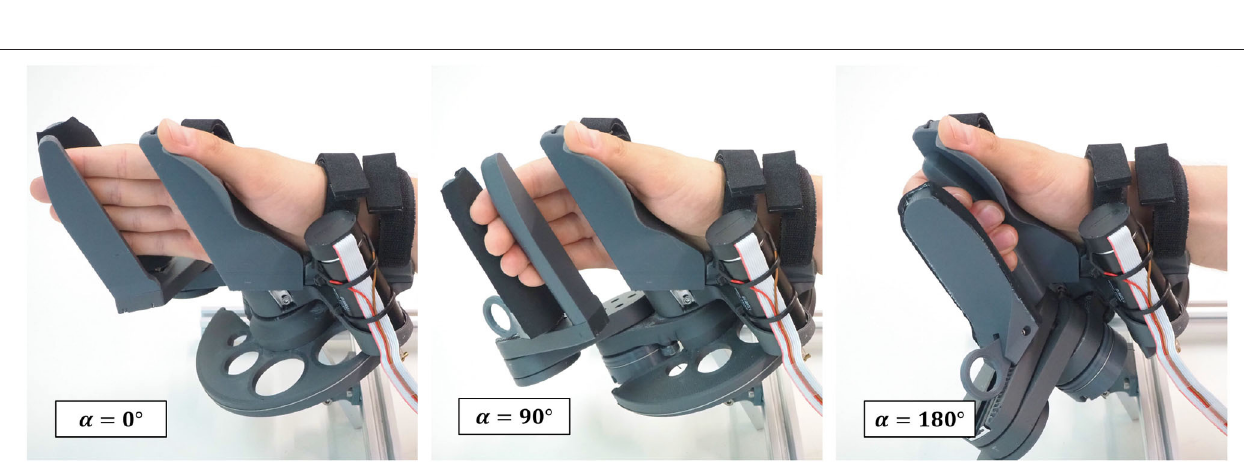
Frontiers in Neurorobotics | www.frontiersin.org